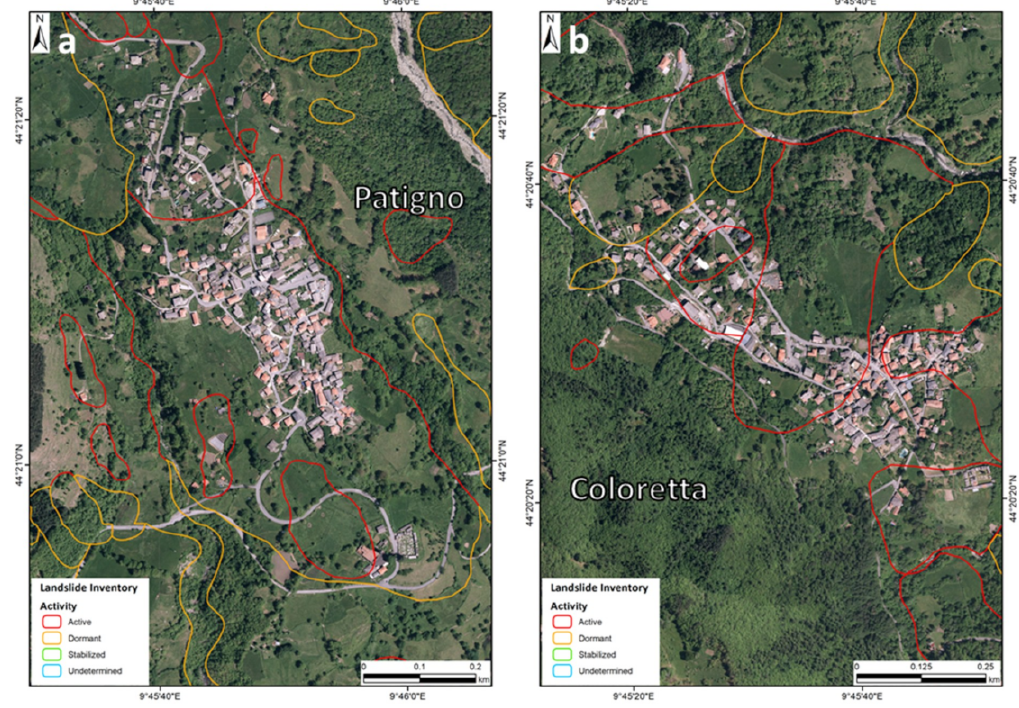
Figure 2. Landslide inventory of the Patigno ( a ) and Coloretta ( b )